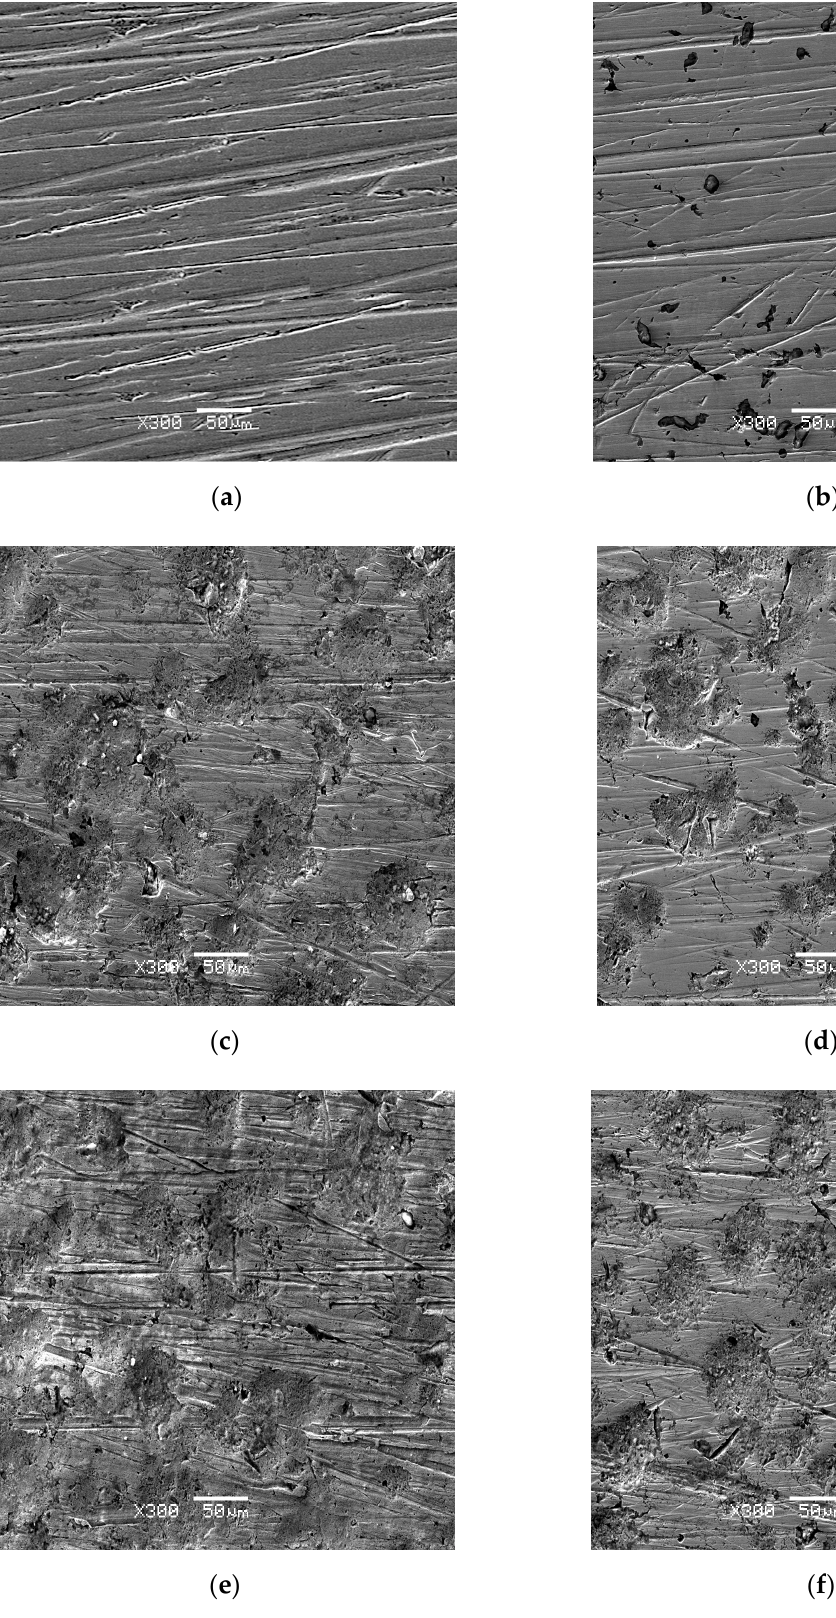
Figure 3. SEM images for the AISI 1010 steel surface in the initial state ( a ) and after 96 h of immersion in sulfolane that contains 0 ( b ), 1 ( c ), 2 ( d ), 4 ( e ) and 6 ( f ) vol.% of water. In order to quantify local changes on the corroded steel surface, the fractal dimension ( D B ) was determined using 2D grayscale images. Generally, the values of fractal dimension can vary in the range of 2 to 3—for a smooth surface, D B is equal to 2, while for a more rough and irregular one, it is closer to 3. Concerning the corrosion resistance of materials, one can state that the more serious the